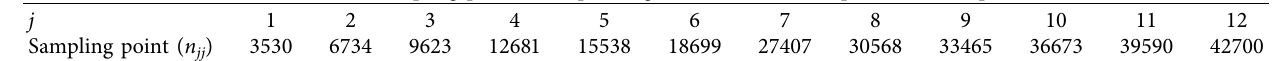
Figure 8: (a) Knocking cylinder and encoder signal collected at 1800r/min. (b) Wavelet time-frequency diagram. Table 2: The sampling point corresponding to the fault feature points of each